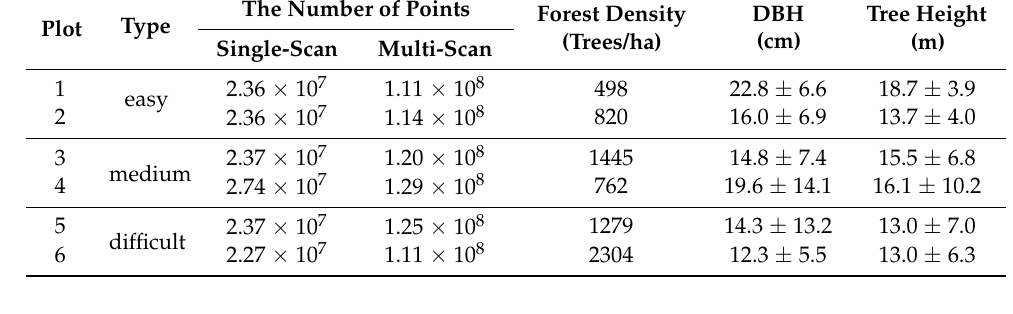
Table 2. Characteristics of the dataset [22,44].